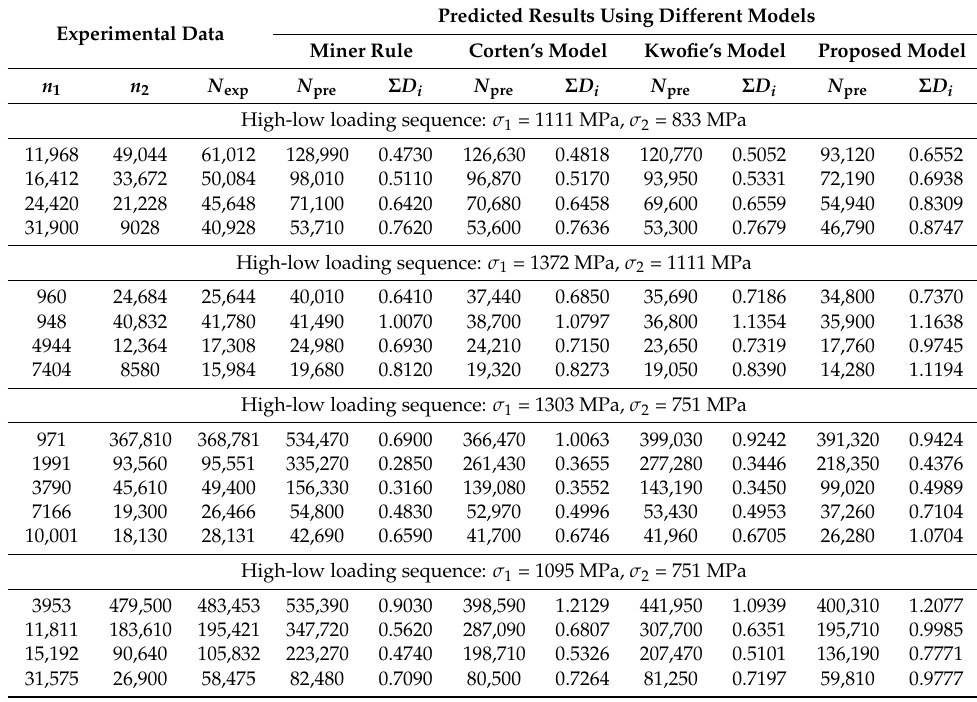
Table 2. Experimental data and models predictions for maraging 300 CVM